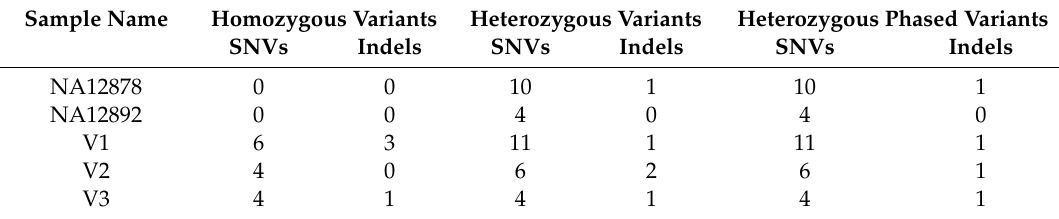
Table 2. Number of total and phased ground-truth variants. For each sample, the table shows the total number of homozygous and heterozygous variants identified by Illumina data and the number of heterozygous variants phased by 10 × Genomics or trio analysis. SNVs = single nucleotide variants, Indels = insertion / deletion variants.